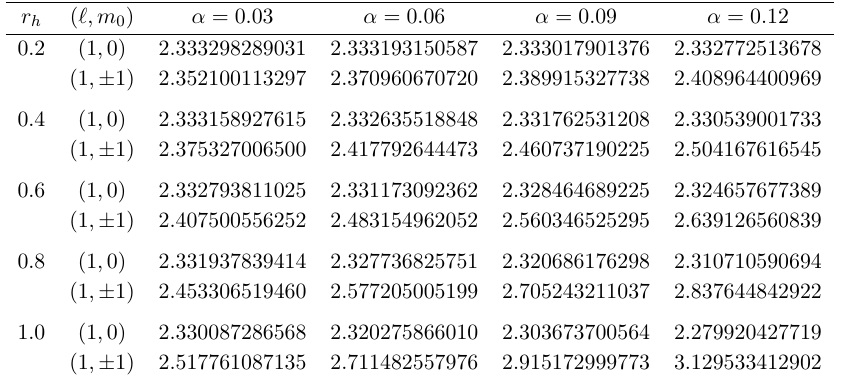
Table 7 . The second ( ‘ = 1 ) angular eigenvalues λ of the accelerating Schwarzschild AdS black hole with Λ = − 3 .